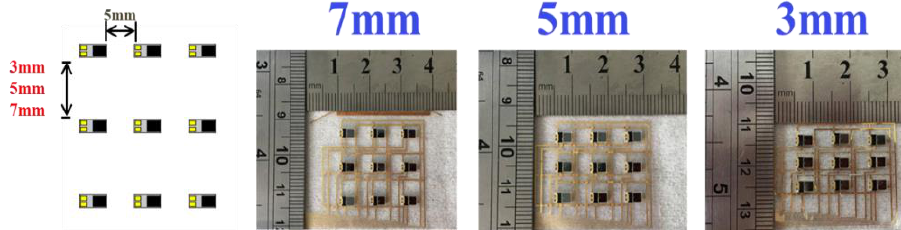
Figure 8. Three sensing element spacing designs: 3 mm, 5 mm, and 7 mm.